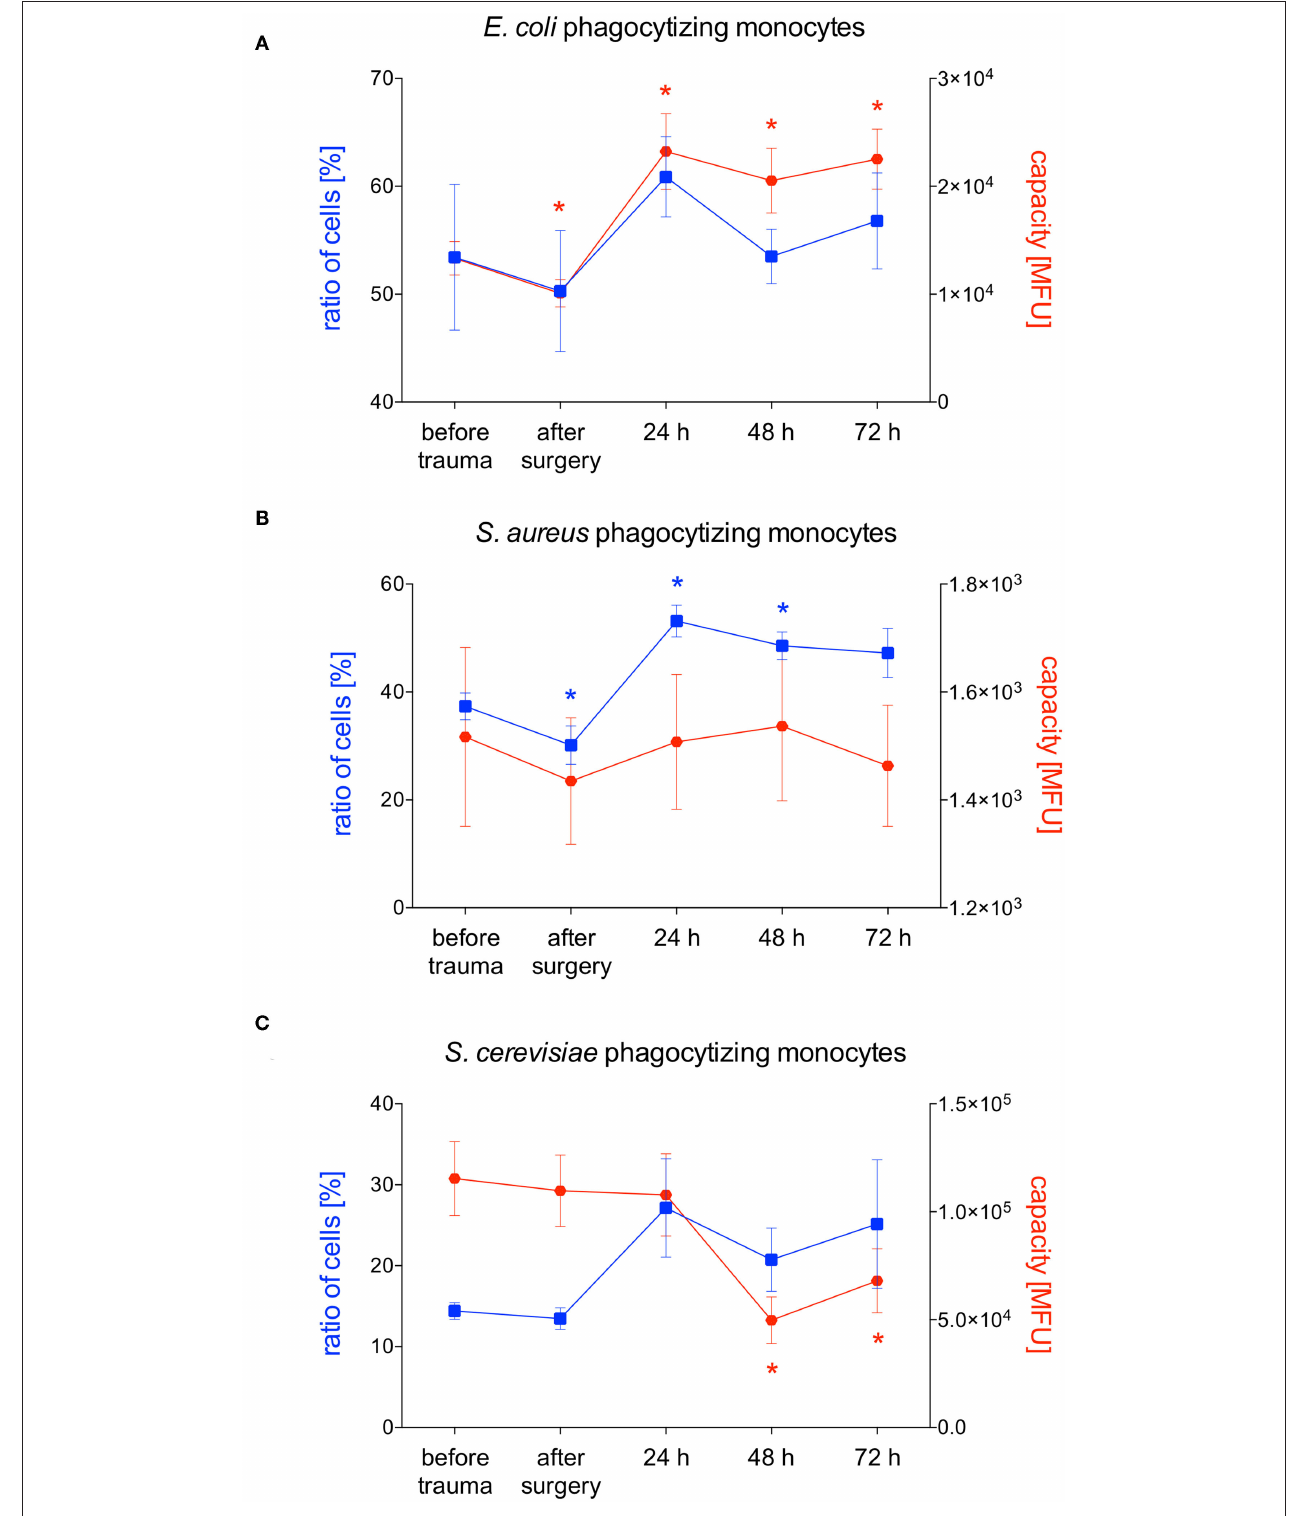
FIGURE 5 | Percentage of phagocytizing monocytes and phagocytic capacity for E. coli , S. aureus or S. cerevisiae . The percentage of phagocytizing monocytes and their capacity to phagocytize E. coli (A) , S. aureus (B) S. cerevisiae (C) was measured with FACS-analysis before trauma, after trauma and after 24, 48 and 72h. Data are given as mean ± standard error of the mean, * p < 0.05 vs. baseline, n = 8.